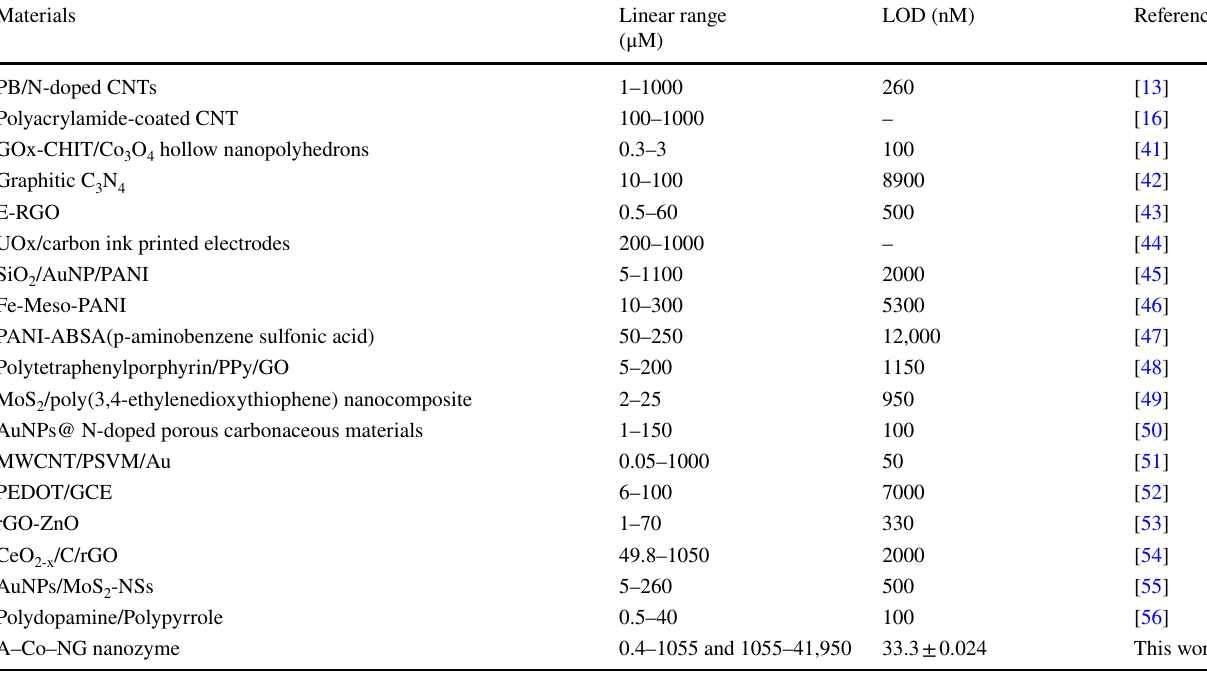
Table 1 Comparison of the performance of the previous studies and this work